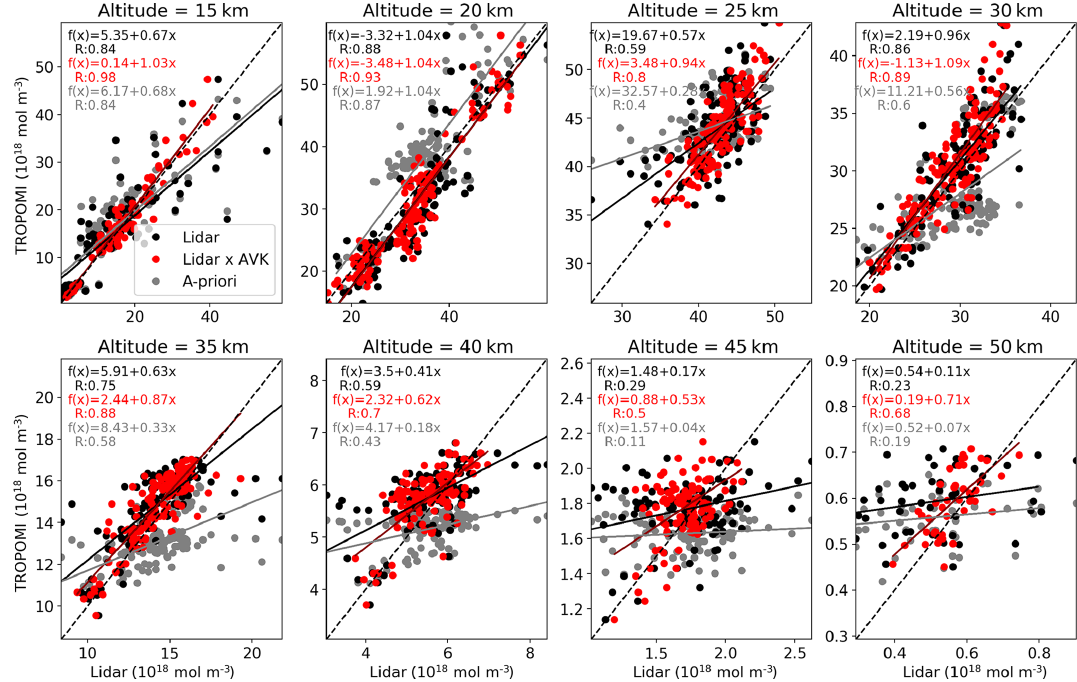
Figure 10. Same as Fig. 8 but for comparison of TROPOMI ozone profiles with lidar